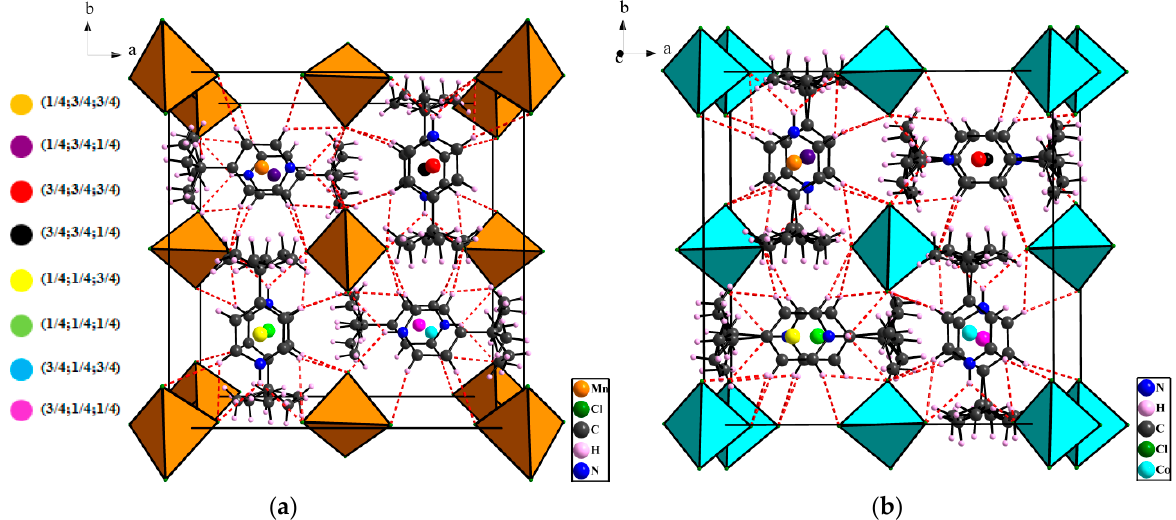
Figure 4. The various locations of organic cations and inorganic anions in the lattices for both compounds: ( a ) compound ( I ); ( b ) compound ( II ).